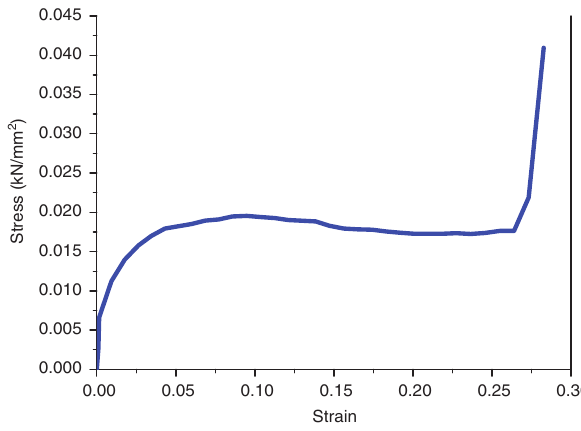
Figure 5: Compressive stress-strain curve of Foam-1.